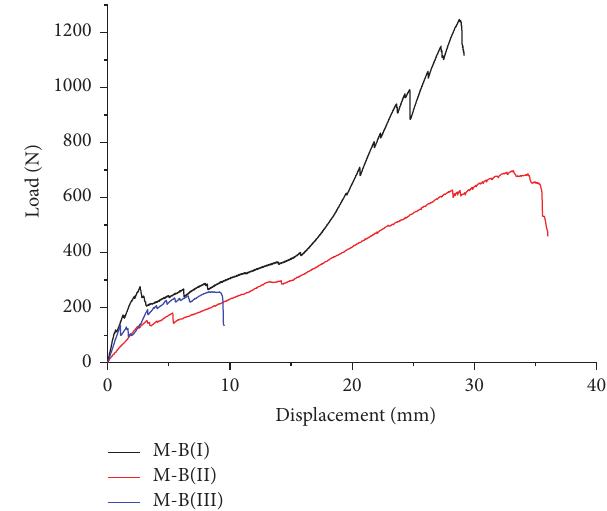
Figure 7: Load-displacement curves of specimens M-B.